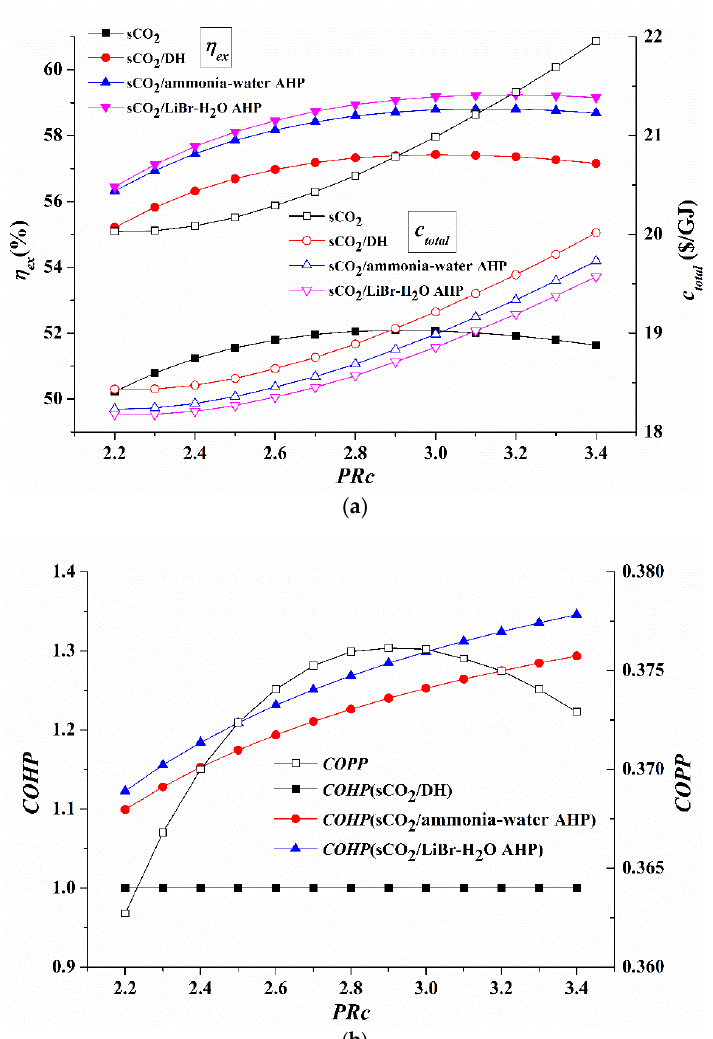
Figure 2. Variation trends of system performance indicators with PRc for different thermal systems: ( a ) η ex and c total ; ( b ) COPP and COHP .